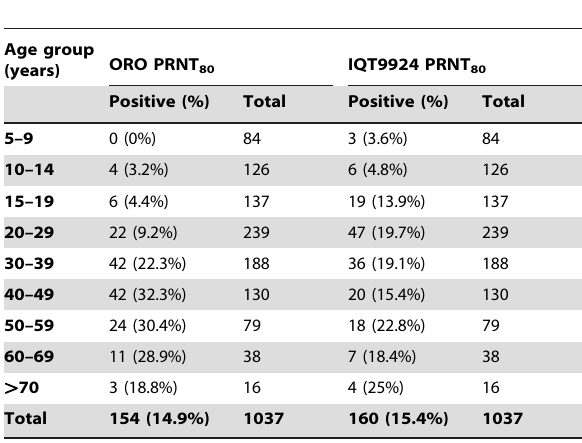
Table 7. ORO and IQT virus antibody prevalence rates by age